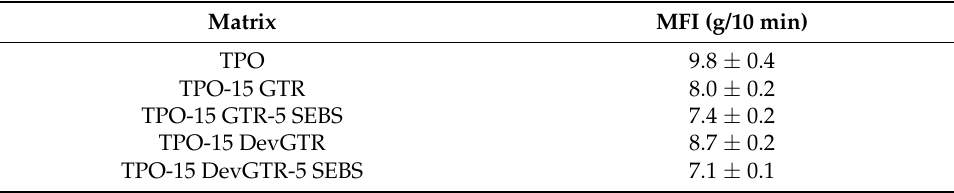
Table 5. MFI values of pristine TPO, TPO-GTR, and TPO-DevGTR materials (200 ◦ C/5 kg).